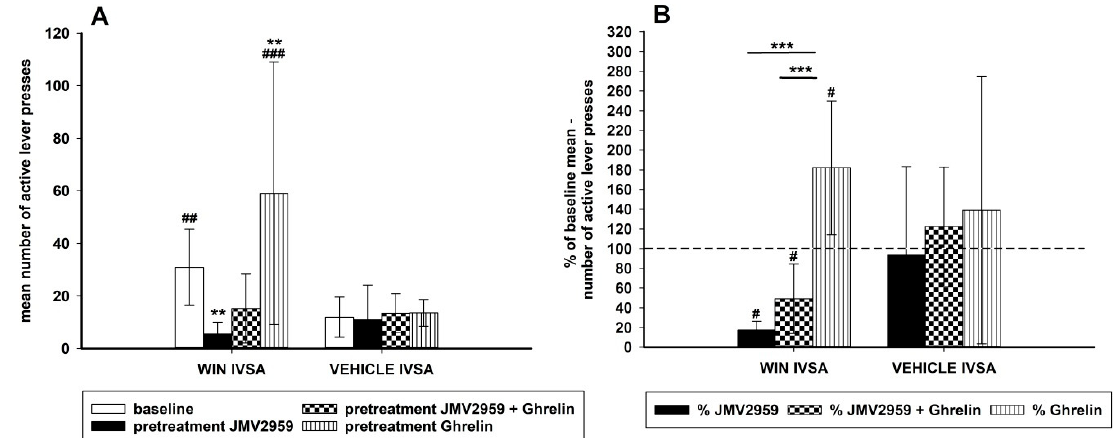
Figure 5. Additional IVSA experiment: Effects of JMV2959 and ghrelin on active lever-pressing for vehicle and for WIN55,212-2 are illustrated in graph ( A ). Baseline pressing (mean of three sessions before pretreatment) was influenced by pretreatment with JMV2959 (3 mg/kg) or JMV2959 + ghrelin or ghrelin (40 µ g/kg) administered intraperitoneally 20 min before the 120-min sessions. The means of the active lever-pressing are presented as follows: basal lever-pressing (open bar), JMV2959 (filled bar), JMV2959 + ghrelin (dotted bar), ghrelin (striped bar). Differences between WIN55,212-2 IVSA and vehicle IVSA are expressed as ## p < 0.01, ### p < 0.001. Differences of pretreatments to baseline lever-pressing are expressed as ** p < 0.01. The effects of pretreatments illustrated in the percentage of the average baseline active lever-pressing (graph B ) are presented as follows: percentage JMV2959 effect (filled bar), percentage JMV2959 + ghrelin effect (dotted bar), percentage ghrelin effect (striped bar). Differences between WIN55,212-2 IVSA and vehicle IVSA are expressed as # p < 0.05. Differences between pretreatments are expressed as *** p < 0.001. Dotted line shows the baseline active lever-pressing (100%). The additional IVSA data went through logarithmic transformation before the statistical analysis; thus, in the graphs are presented original data together with significances obtained from the transformed ANOVA results. The results are presented as group means with 95% confidence intervals ( n = 4).